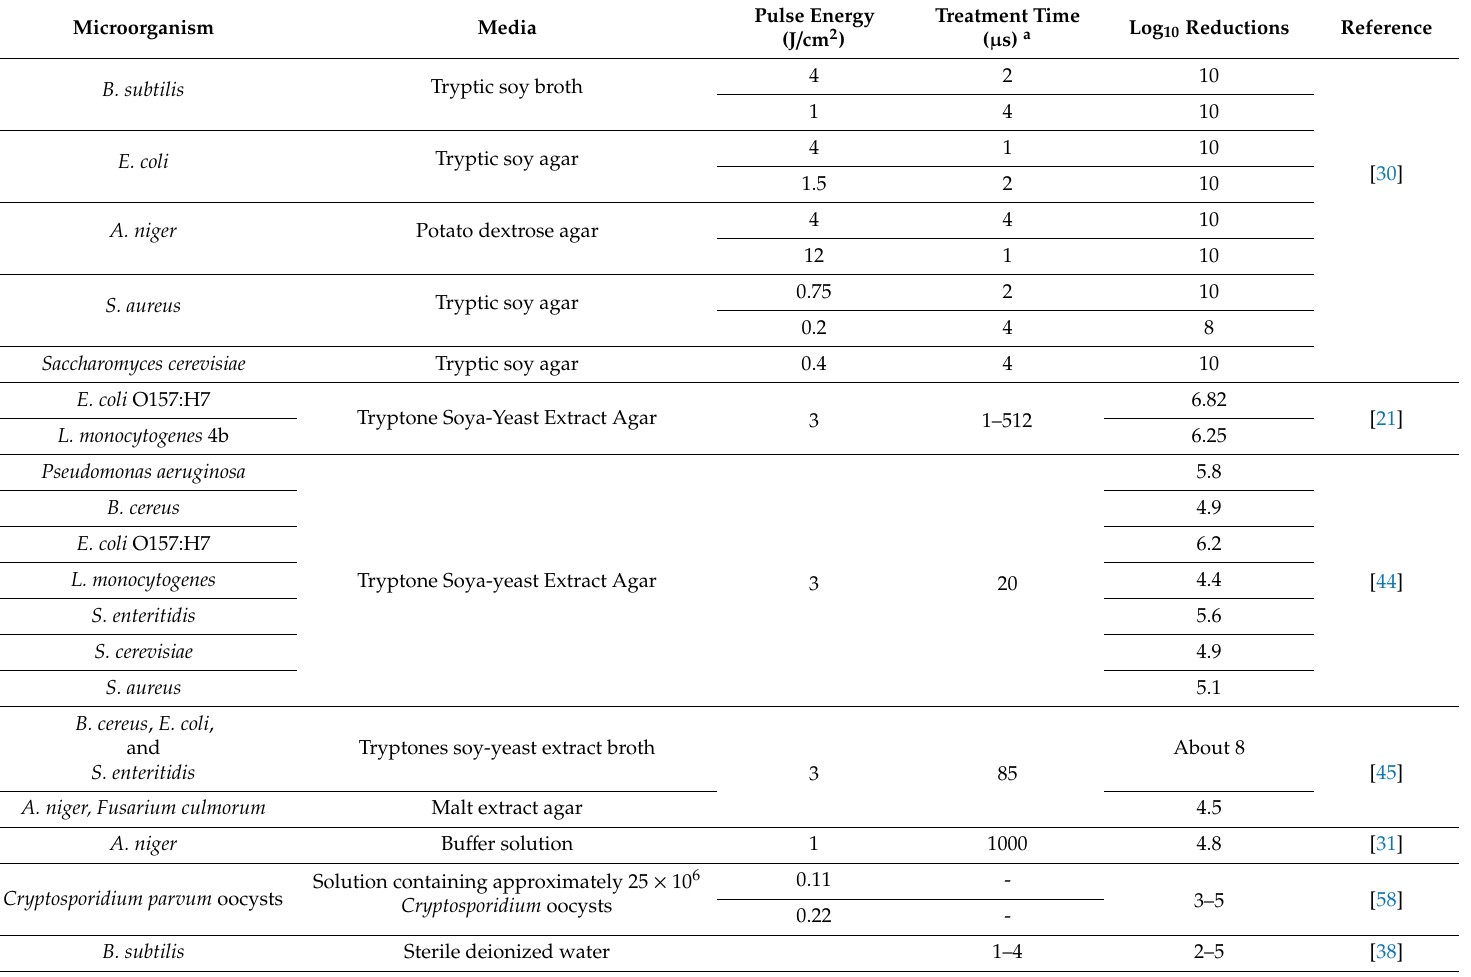
Table 3. The e ff ects of PL treatments on microbial inactivation in vitro based on several published data.